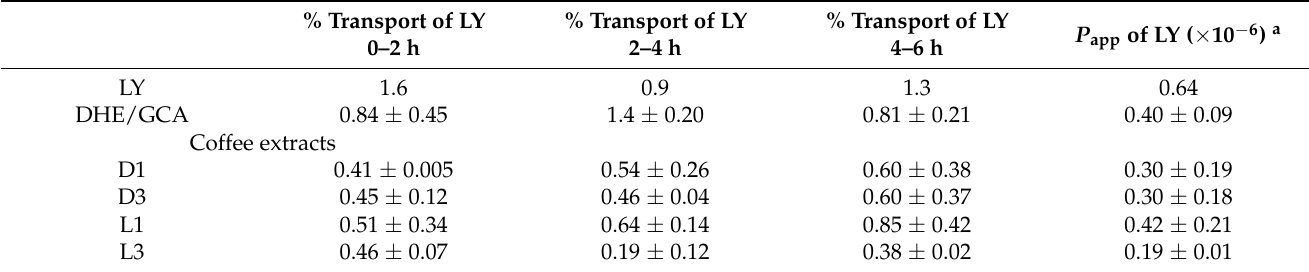
Table 1. Amount of LY transported and corresponding permeability coefficient in permeability assays through Caco-2 monolayers with a multi-time point assay with sampling at 2, 4 and 6 h. Effect of DHE (10 µ M) emulsified by GCA (10 mM), in the absence and presence of coffee extracts, n = 2. % Transport of